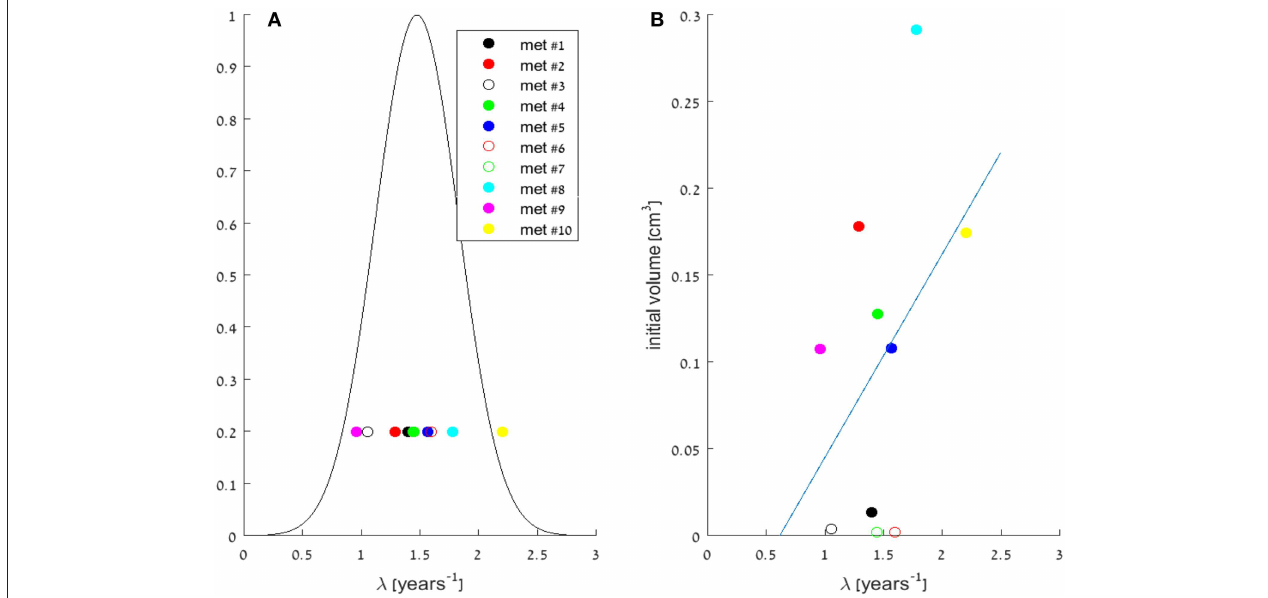
FIGURE 2 | (A) Distribution of the growth rate parameter λ in the fitted exponential models for the 10 metastases. Circles are the specific values of λ , for all metastases (as detailed in Table 2 ), and a gaussian curve is presented, assuming normal distribution around the mean value: 1.48 years − 1 , with standard deviation of 0.34 years − 1 . (B) Scattering of the growth rate parameter λ vs. initial metastases’ volumes, measured at time W1. Circles are the specific values, for all metastases, and a linear model trendline of their correlation is presented. No significant correlation was observed (correlation coefficient